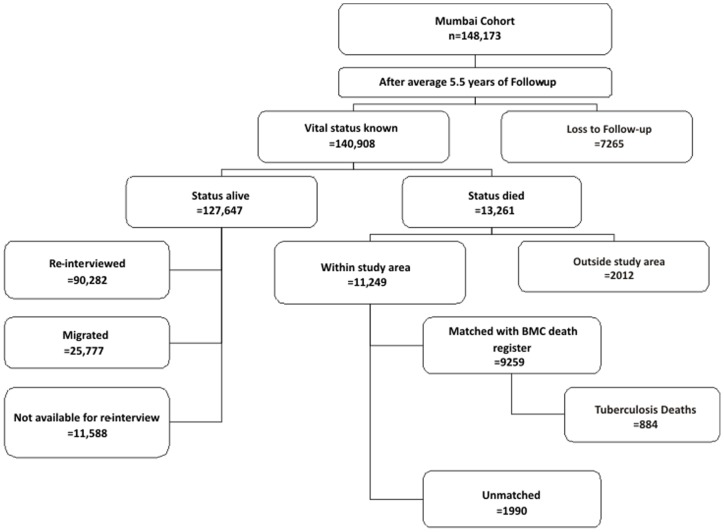
Flow diagram of house-to-house follow-up of the study participants, Mumbai Cohort Study, India.